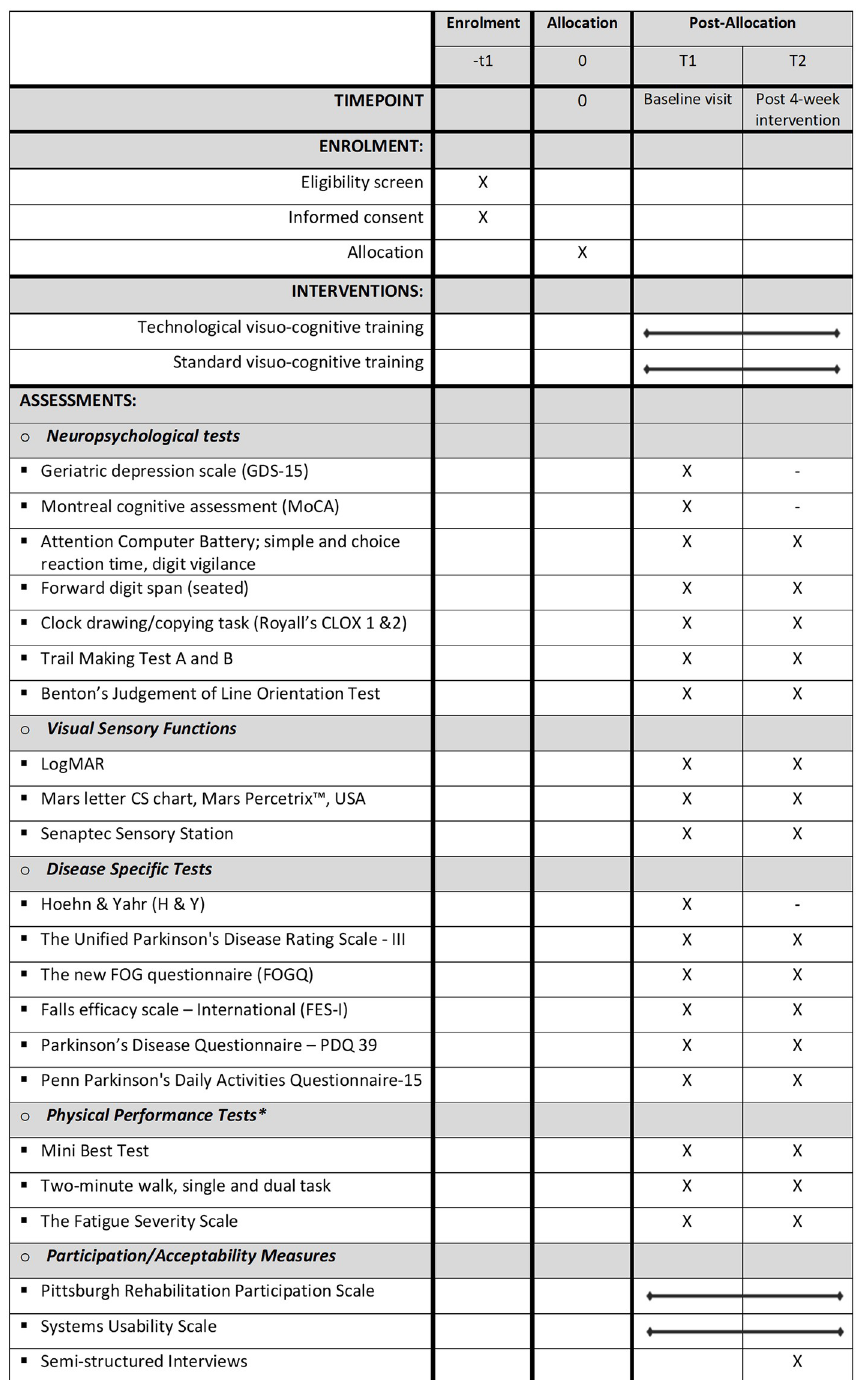
Fig 1. SPIRIT schedule of enrolment, interventions, and assessments.